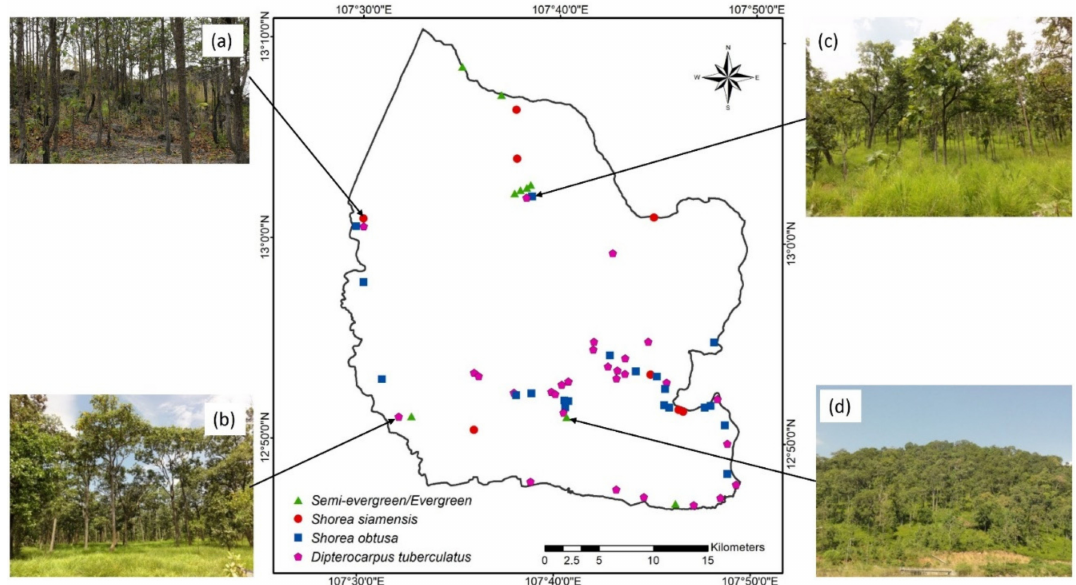
Figure 10. Location of 66 field survey plots for validation and field photos: ( a ) Shorea siamensis , ( b ) Shorea obtusa , ( c ) Diptero- carpus tuberculatus , and ( d ) semi-evergreen/evergreen